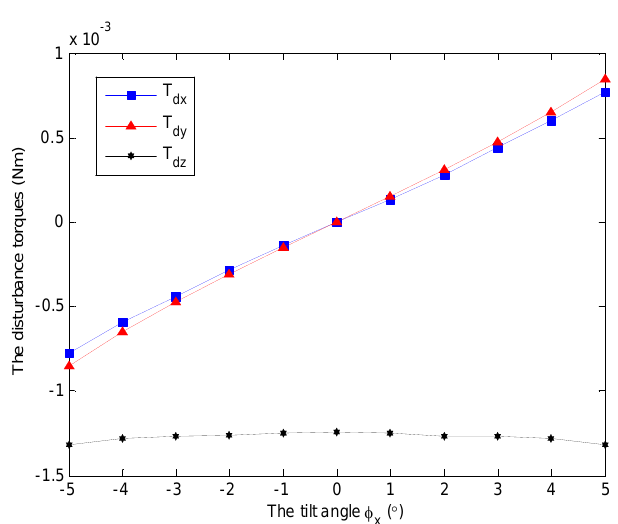
Figure 8. Simulation results of the disturbance torques T dx , T dy and T dz with varying tilt angles φ x under φ y = 0 ◦ and 3500 rpm.